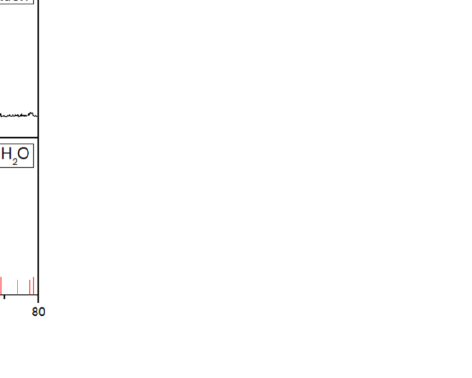
Figure 9. XRD analysis of CuC 2 O 4. Table 5. EDS analysis of CuC 2 O 4.